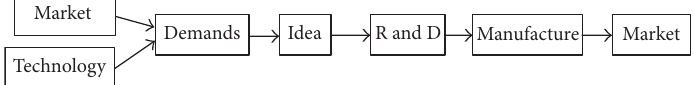
Figure 1: The ITISA constitutes complete technology innovation chain.